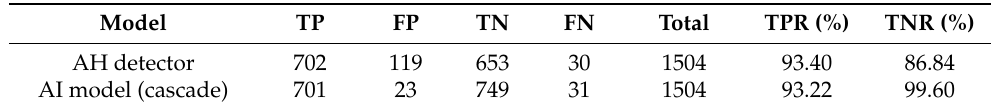
Table 7. Comparison between a single model and a model with a cascade structure to observe an increase in specificity and a decrease in